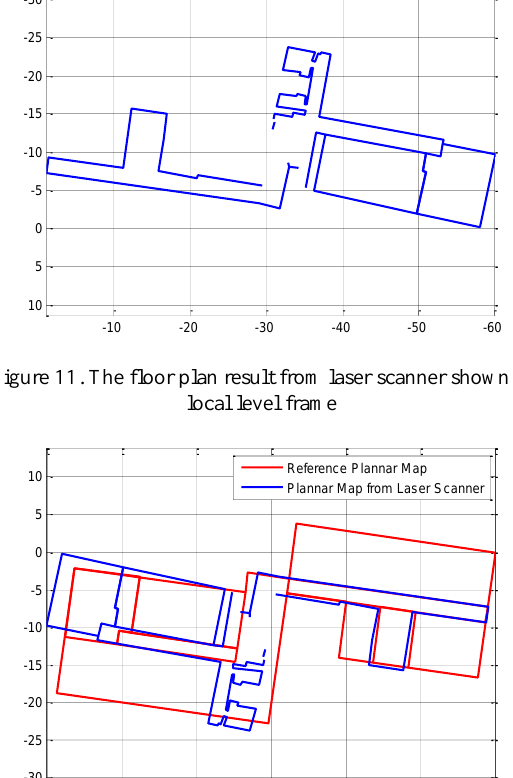
Figure 9. The floor plan result from Kinect sensor shown in